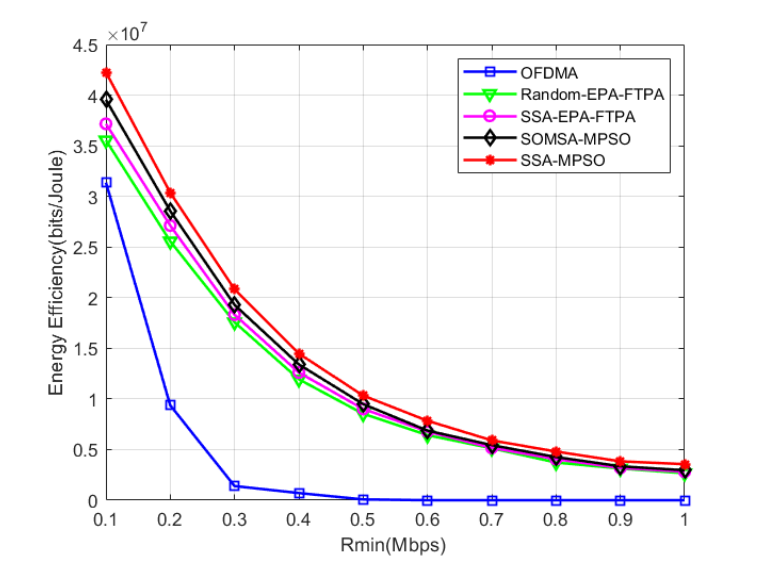
Figure 9. Energy efficiency versus minimum data transmission rate